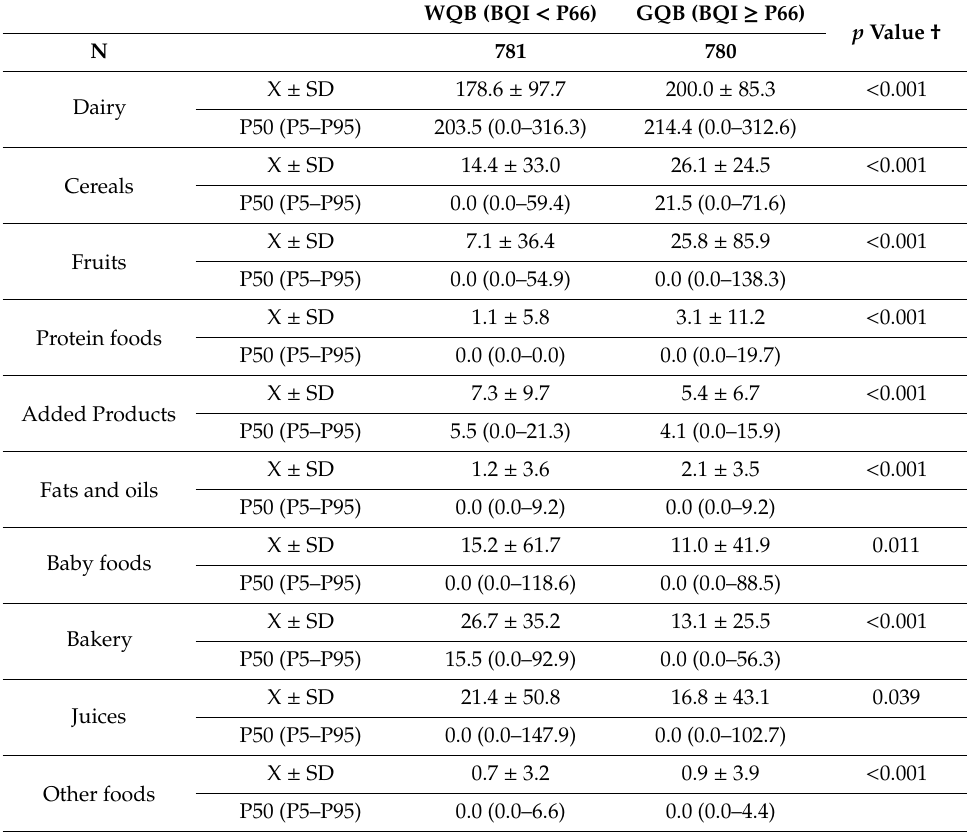
Table 4. Breakfast food consumption by breakfast quality group (g / day adjusted by energy).